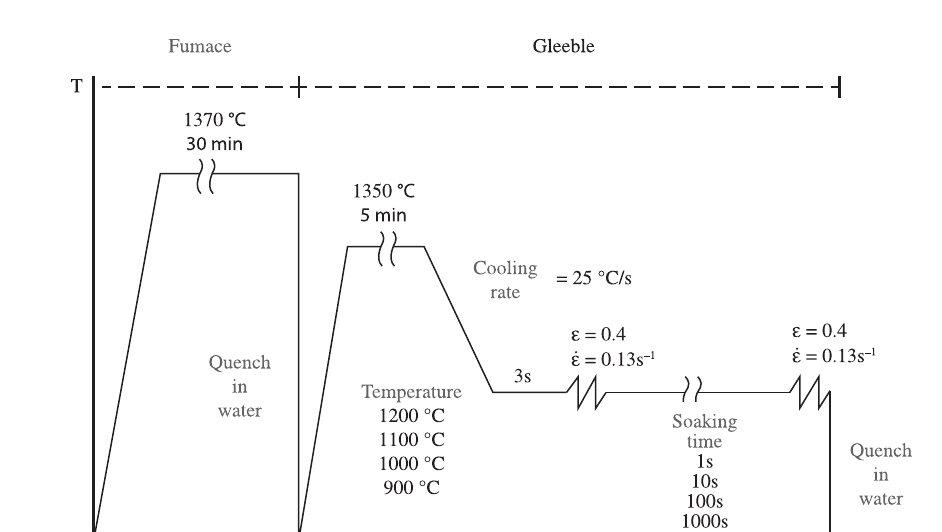
Figure 1. Annealing curve and thermomechanical treatment schedule for compression testing.